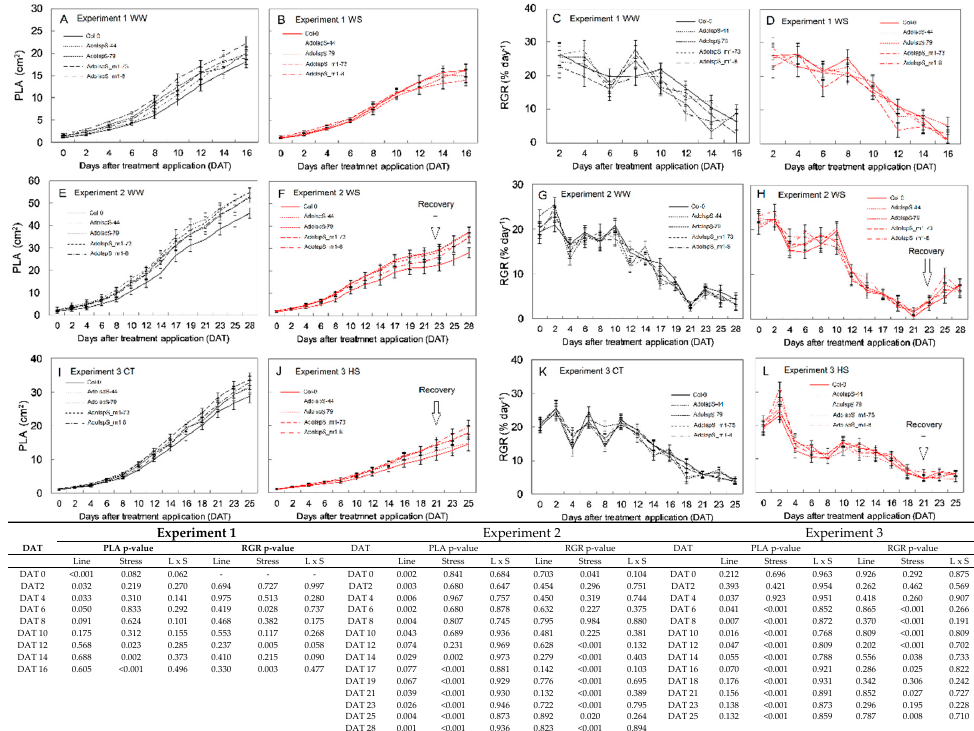
Figure 5. Projected leaf area (PLA) and relative growth rate (RGR) of Col-0 and isoprene- or ocimene-emitting lines. Data were collected over three experiments and during the entire experimental treatment. In ( A , E , I ), continuous assessment of PLA for control plants (WW in Experiment 1 and 2 or CT in Experiment 3) and in ( C , G , K ), the calculated RGR is shown. In ( B , F , J ), continuous assessment of PLA for stressed plants (WS in Experiment 1 and 2 or HS in Experiment 3) and in ( D , H , L ), the calculated RGR is shown. Values are means ± standard error of the means ( n = 12 while n = 10 in Experiment 1). Data were subjected to repeated measurements analysis ( p < 0.001) and two-way ANOVA and the output is shown in the table for each experiment. A multiple comparisons test (Fisher’s test) was carried out for each day after treatment (DAT) and is shown in Supplementary 2 for